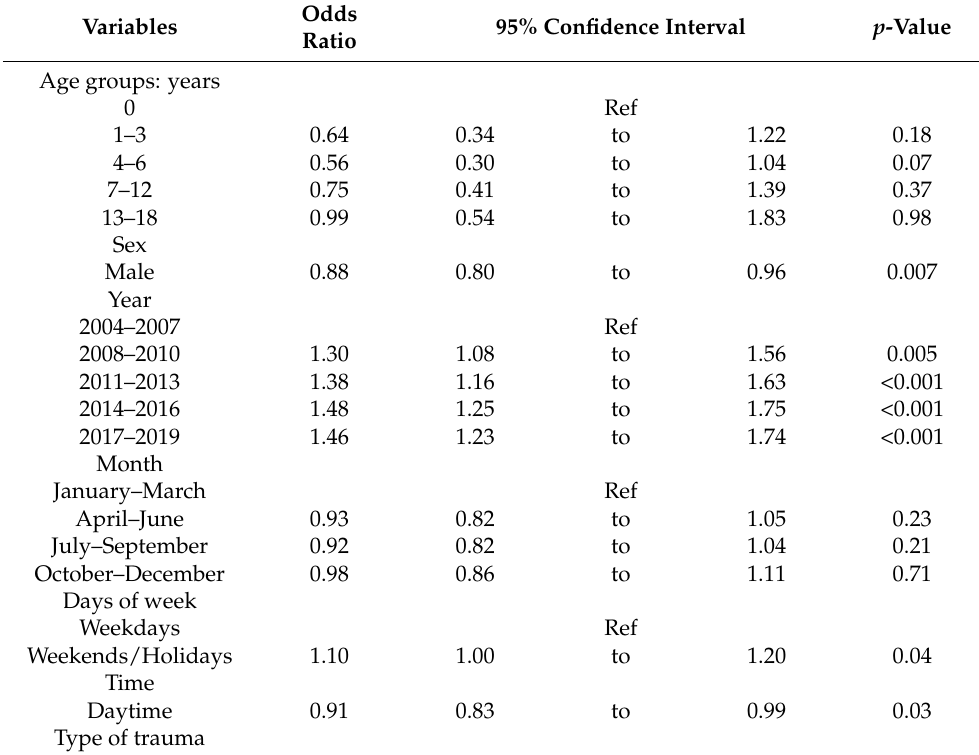
Table 4. Multivariable logistic regression analysis with complete